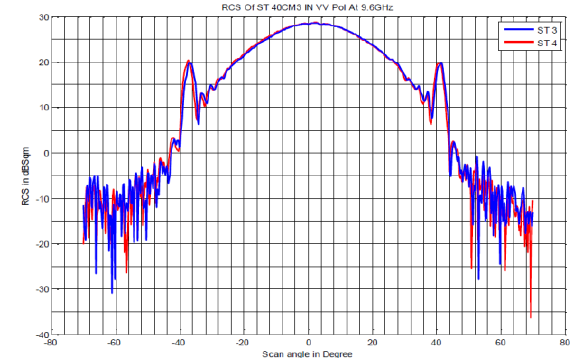
Figure 4(a): Plot of measured RCS values of ST_40cm_3,